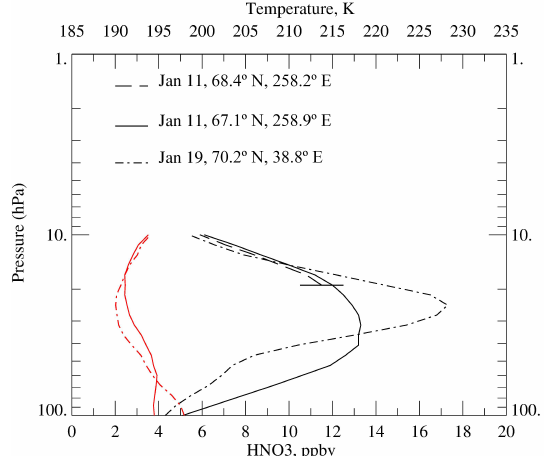
Figure 5. Profiles of LIMS V6 nitric acid vapor (in black) and two co-located profiles of temperature (in red) for 11 and 19 January. Horizontal line at 19hPa marks the cutoff level for valid nitric acid on 11 January and at 68.4 ◦ N, 258.2 ◦